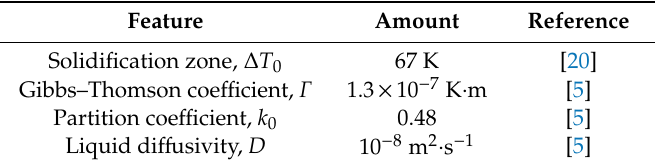
Table 5. Material characteristics of the AA5456 used in the Kurz and Fisher (KF)